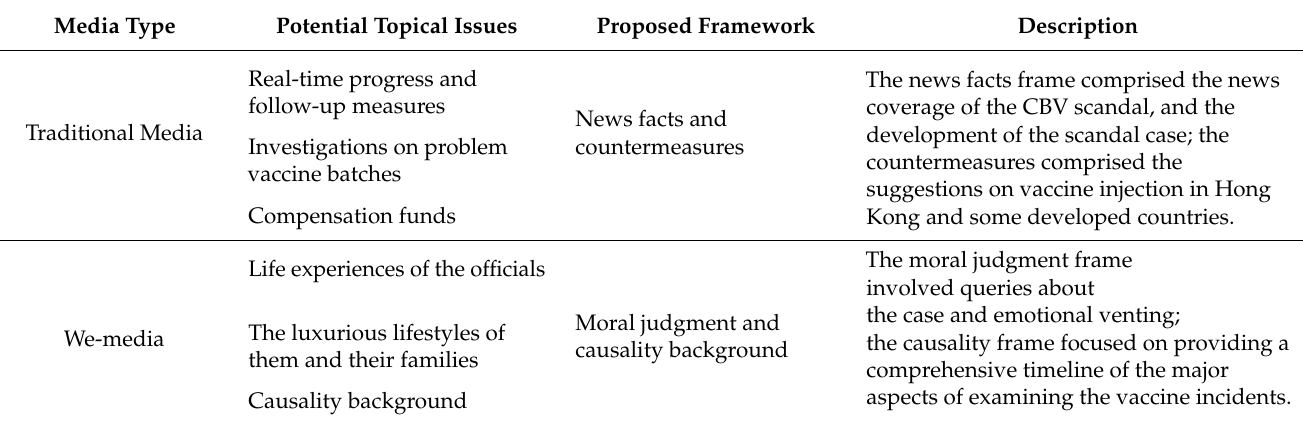
Table 1. The potential topical issues and proposed